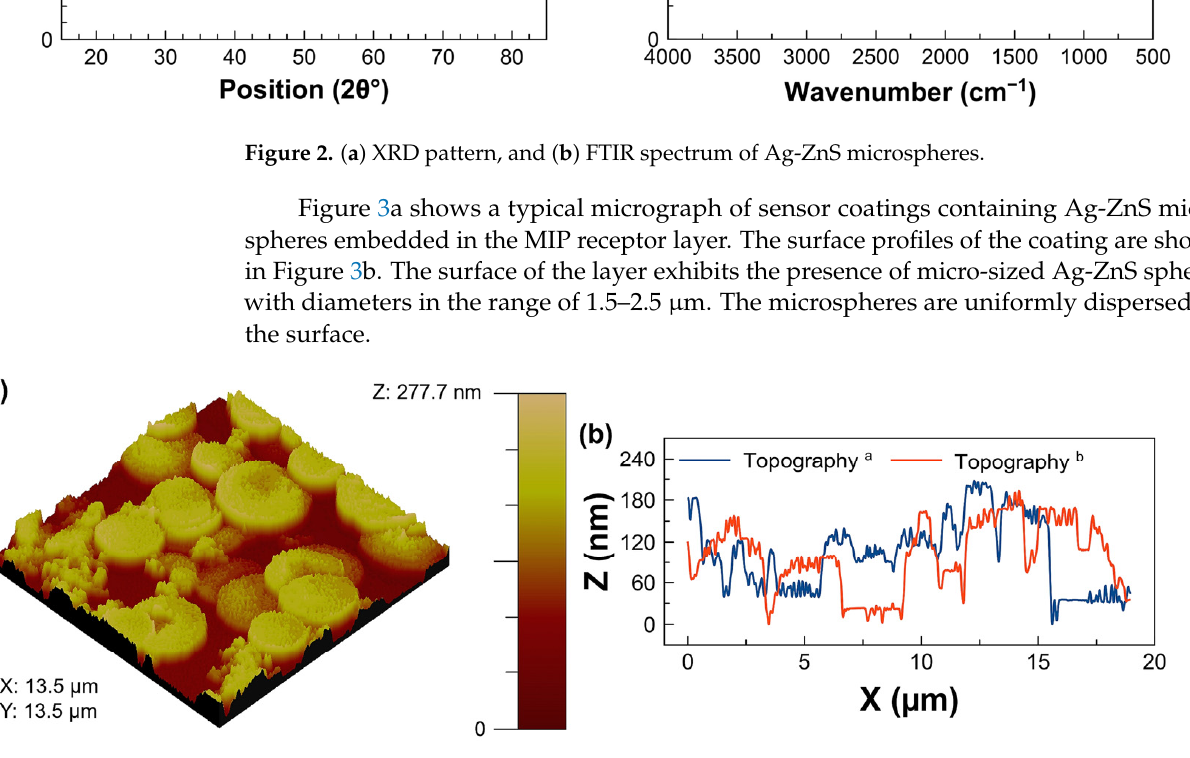
Figure 3. ( a ) A micrograph of the receptor layer showing Ag-ZnS microspheres, ( b ) topographic surface profiles of the receptor layer showing surface features from bottom-to-top (Topography a ) and across right-to-left (Topography b ) of surface in ( a ).